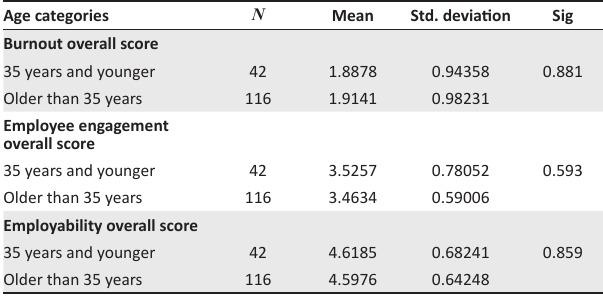
TABLE 7: Significant mean differences: Age.